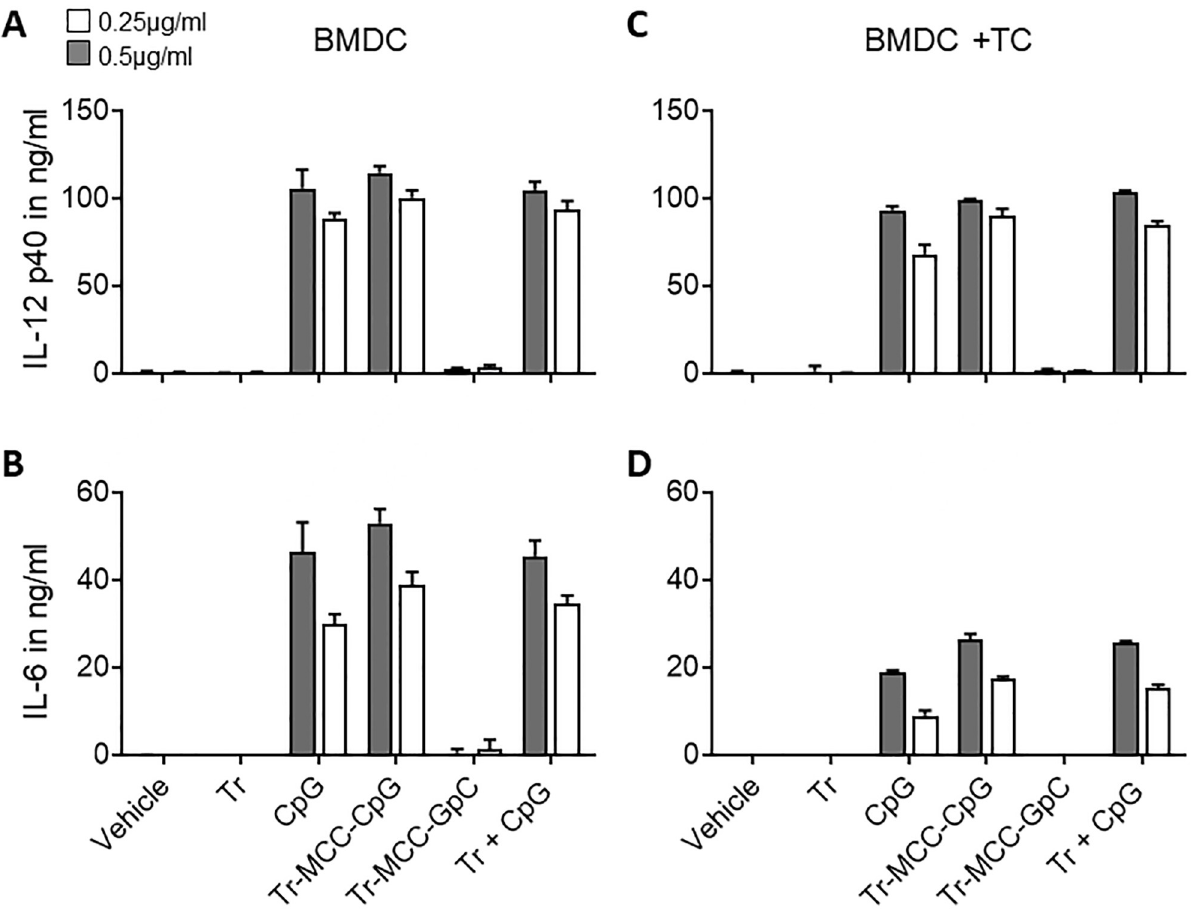
Fig 2. The stimulatory activity of conjugated CpG ODN was evaluated in vitro in DC activation assays. 0.2x10 5 GM-CSF BMDC were stimulated overnight alone (A, B) or in the presence of 4x10 5 B14.3 HER2 tumor cells (C, D) with 0.25ug/ml (grey bars) and 0.5ug/ml (white bars) of ODN, either free (stimulatory CpG ODN) or conjugated (stimulatory CpG and non-stimulatory GpC ODN) with SMCC to Trastuzumab. Untreated samples (Vehicle) Trastuzumab and Trastuzumab-MCC-GpC conjugates were used as negative control. A combination of unconjugated Trastuzumab and CpG ODN (Tr +CpG) was also tested. IL-12p40 (A, C) and IL-6 (B, D) in the supernatants of overnight cultures was measured by sandwich ELISA. Data are mean ± SD of three technical replicates and is representative of three independent experiments with different batches of conjugates.